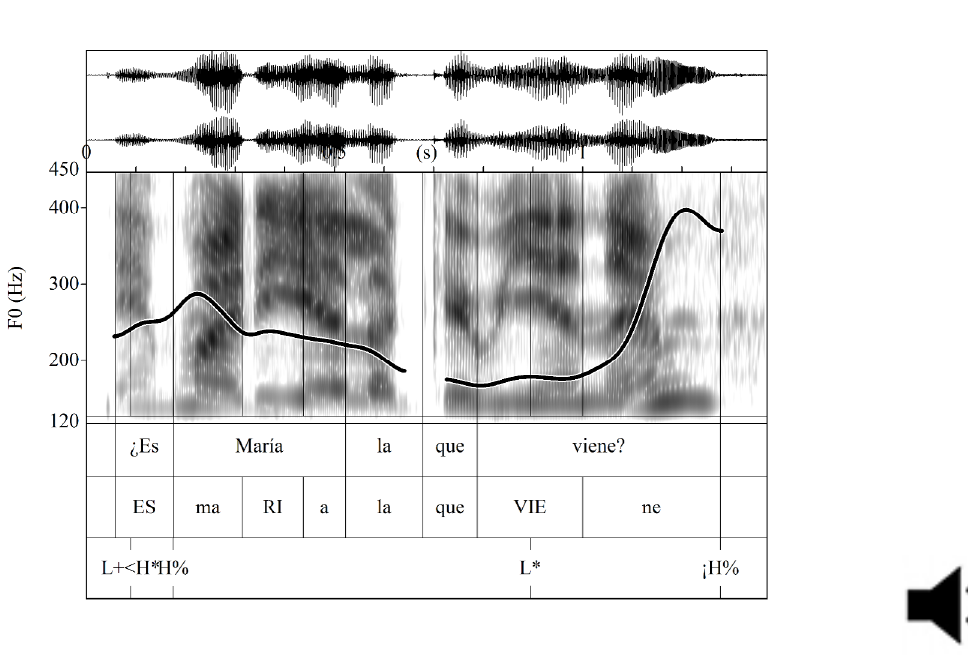
Figure 13 (Participant 22): Waveform and F0 trace for the emphatic yes-no question ¿ Es María la que viene? ‘Is María the one who’s coming?’ produced as two IPs: L+<H* H% (1 st IP nuclear configuration) and L* ¡H% (2 nd IP nuclear